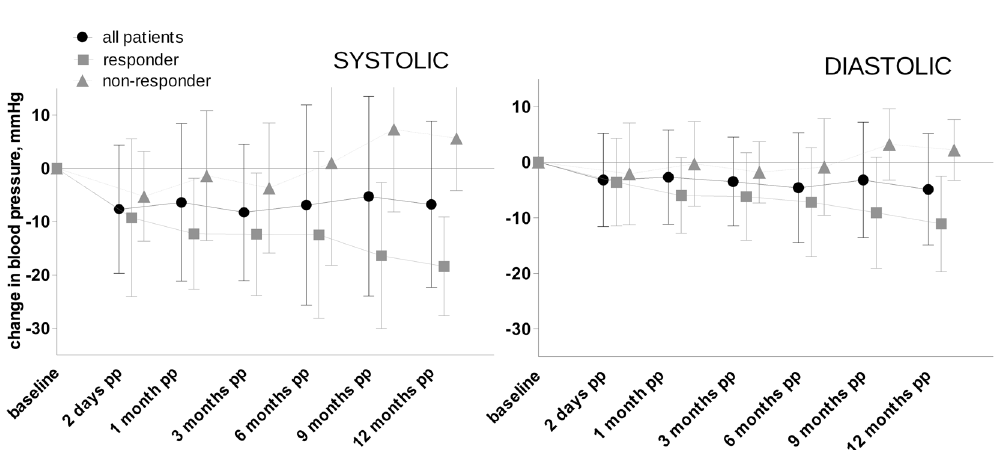
Figure 2. Mean changes in 24 h ambulatory systolic and diastolic blood pressure at 2 days, 1, 3, 6, 9 and 12 months after RDN (pp- post procedure); whiskers represent standard